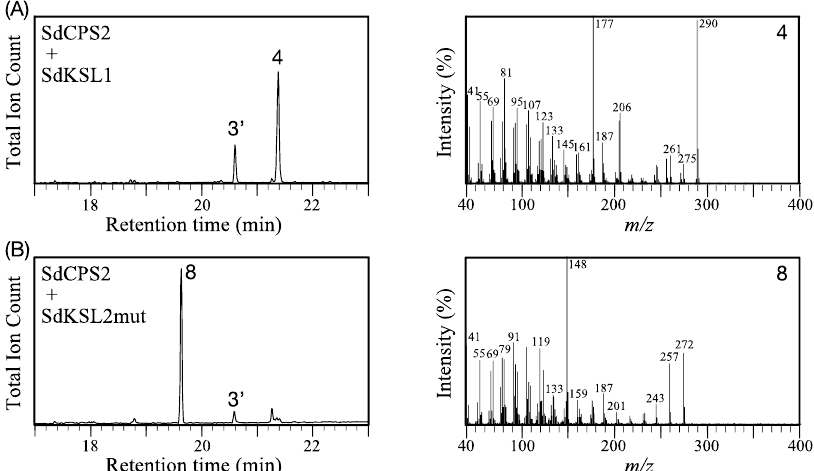
Figure 3. GC-MS analyses of extracts from cultures expressing the indicated gene products. Shown are the total-ion-count (TIC) chromatograms on the left, and mass spectra for the indicated peak on the right. ( A ) Production of 4 (scopadula-13 α -ol) by SdCPS2 and SdKSL1. ( B ) Production of 8 (aphidicol-16-ene) by mutated SdKSL2mut.